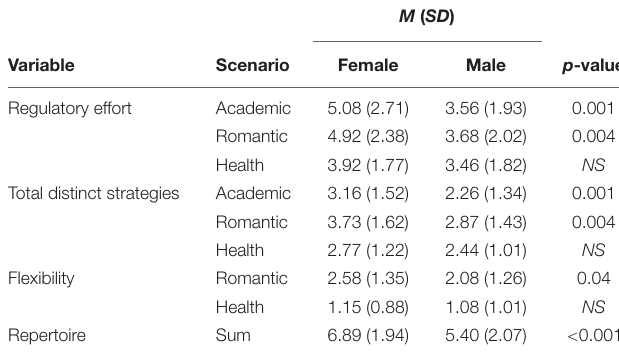
TABLE 3 | Means and standard deviations of gender differences in emotion regulation flexibility